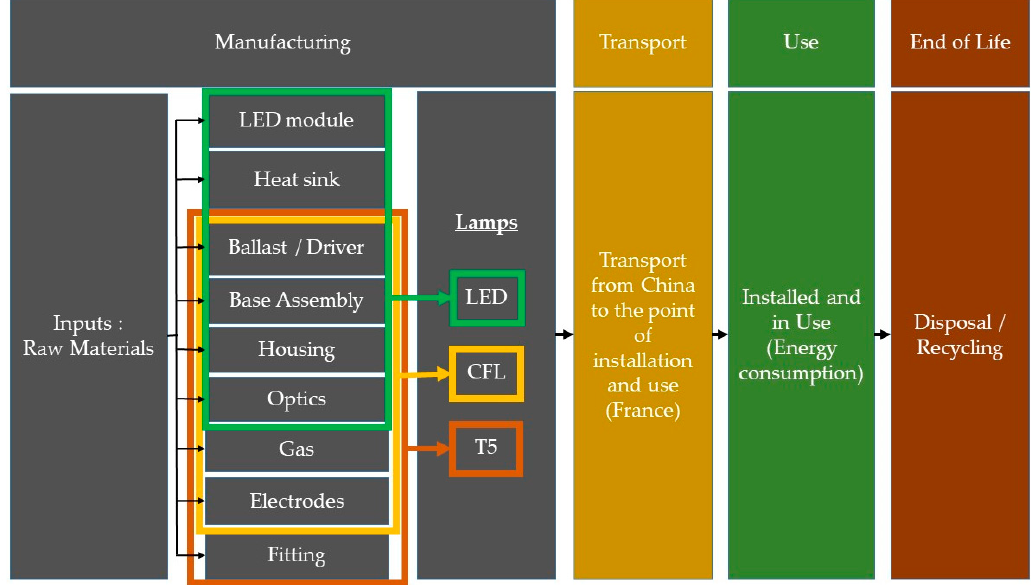
Figure 2. System boundaries (Adapted from Navigant UK [4] and US Department of Energy (DOE) [5]).